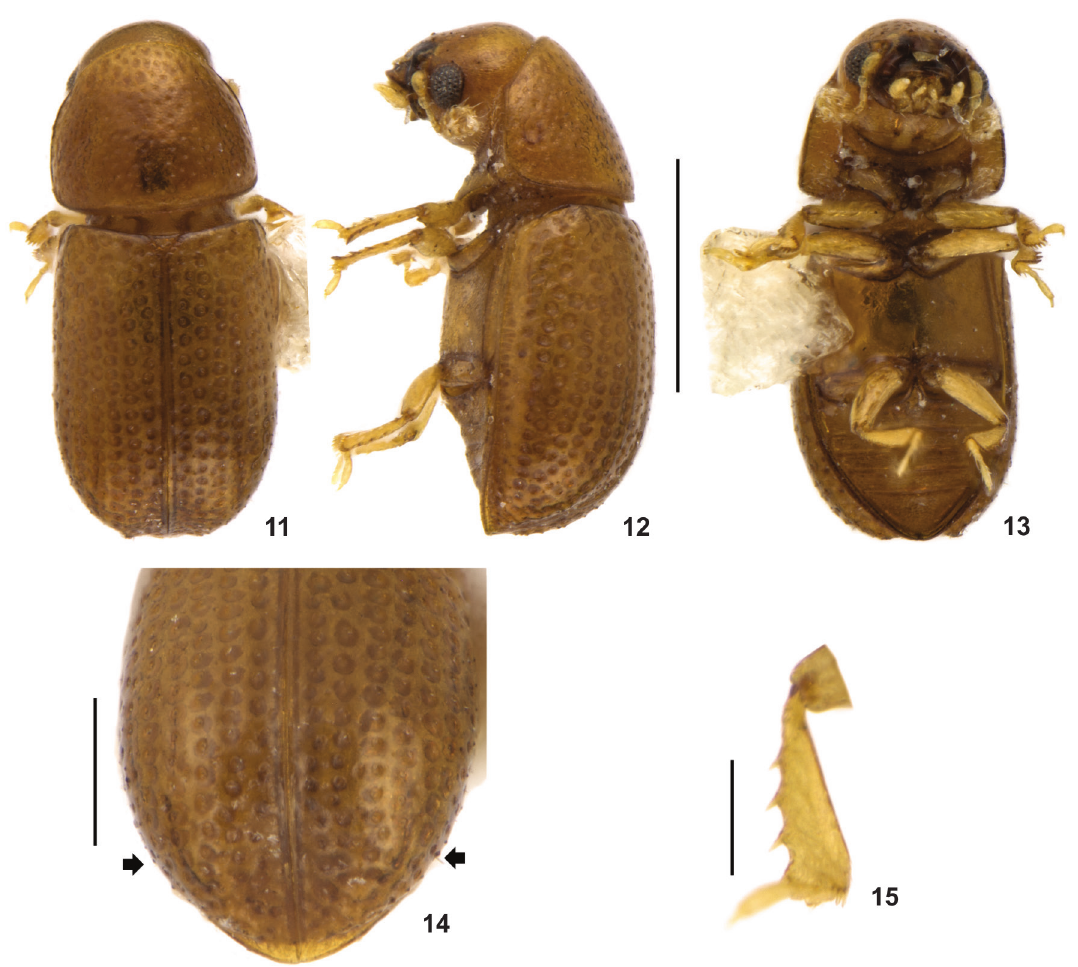
Figures 11–15. Scolytocis samoensis from Guam, Micronesia: (11) dorsal view; (12) lateral view; (13) ventral view; (14) apical declivity of elytra; (15) left metatibia. Scale bars: 0.5 mm (11–13); 0.2 mm (14); 0.1 mm (15). concave with conspicuous cuticular globules (Fig. 14,